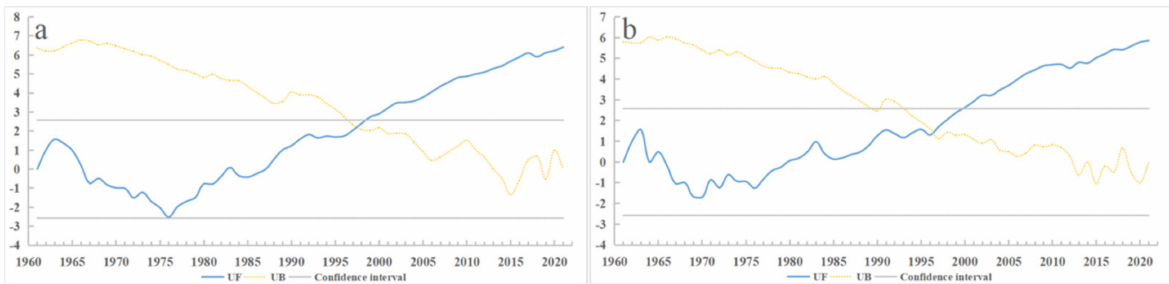
Figure 9. The mutation temperature change curve in Xinjiang, 1961–2021 (( a ) the spatially homoge- nized revised average; ( b ) the equal-weighted